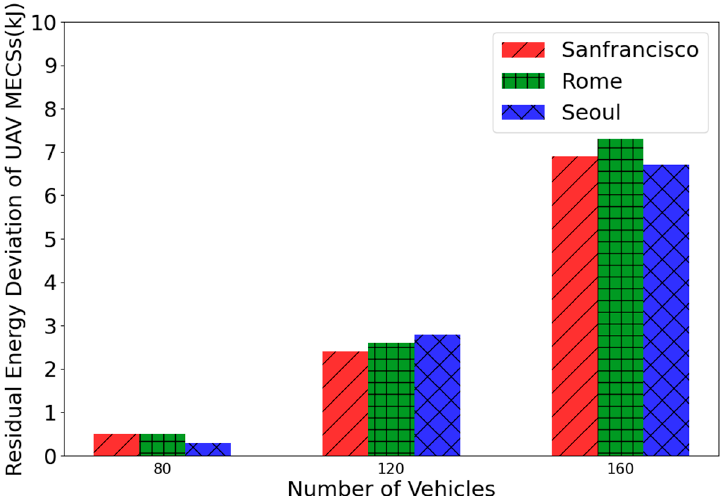
Figure 7. Residual energy deviation of UAV MECSs with varying number of vehicles in different environments.